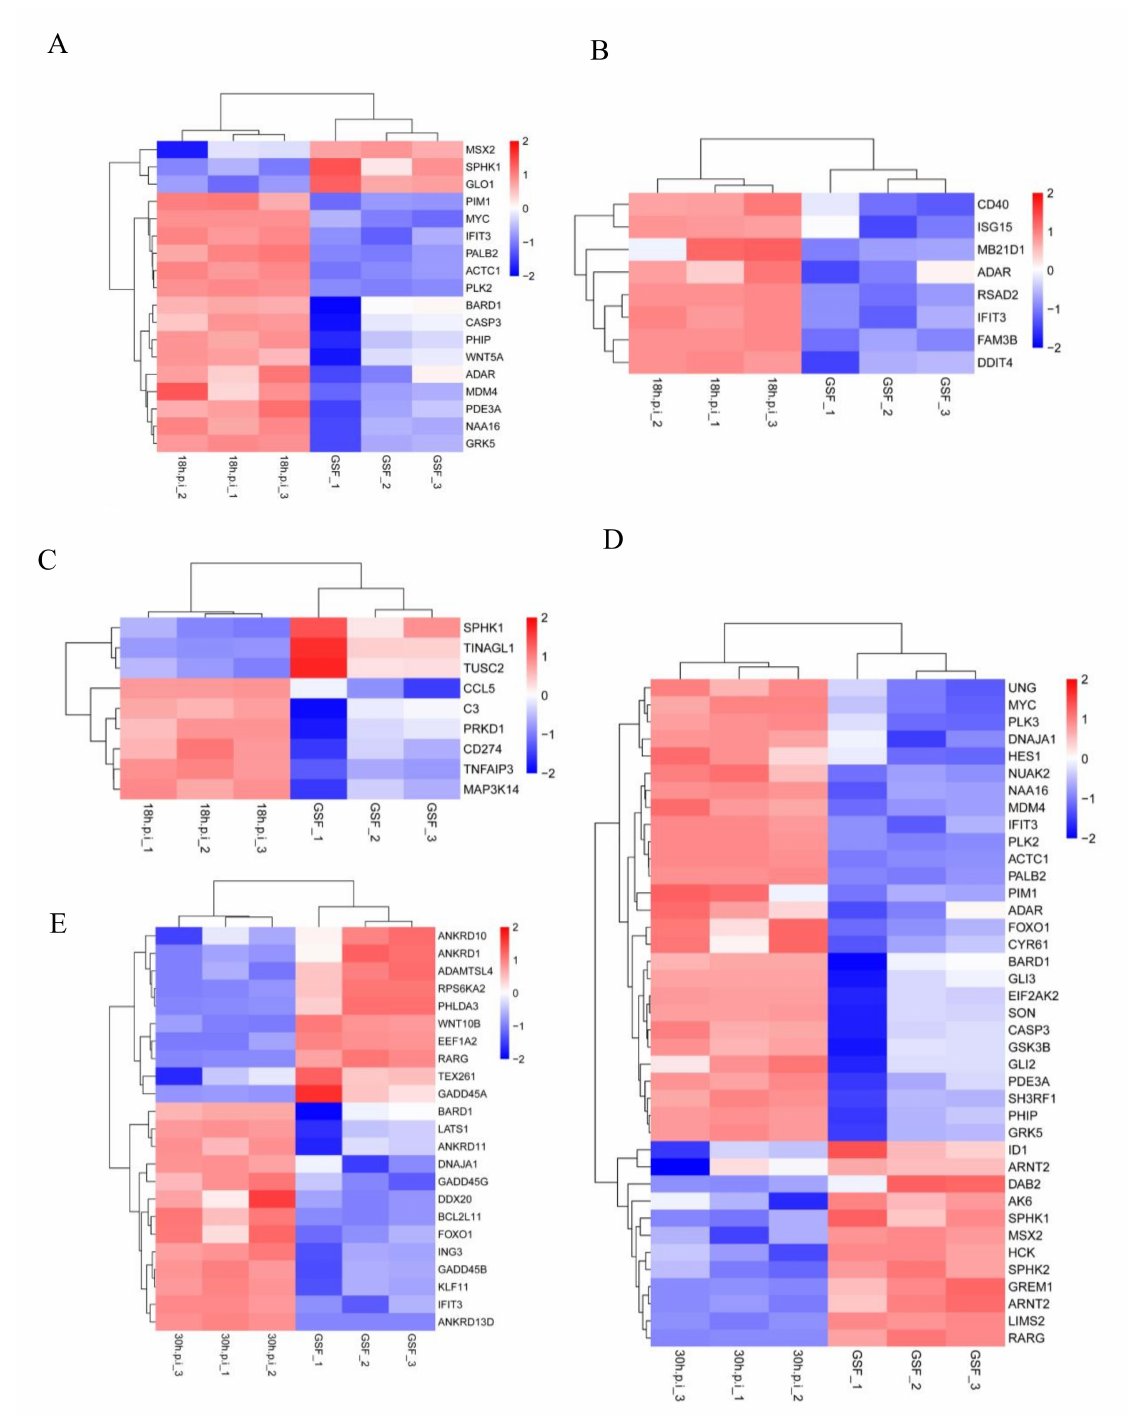
Figure 6. The clustered heatmaps of cellular immune response genes in the 18h.p.i vs. GSF comparison and positive and negative regulation of apoptosis genes identified in the 30h.p.i vs. GSF comparison. ( A ) Heatmap of DEGs enriched in negative regulation of apoptotic process in the 18h.p.i vs. GSF comparison. ( B ) Heatmap of DEGs enriched in defense response to virus in the 18h.p.i vs. GSF comparison. ( C ) Heatmap of DEGs enriched in immune and inflammatory response in the 18h.p.i vs. GSF comparison. ( D ) Heatmap of DEGs enriched in negative regulation of apoptotic process in the 30h.p.i vs. GSF comparison. ( E ) Heatmap of DEGs enriched in positive regulation of apoptotic process in the 30h.p.i vs. GSF